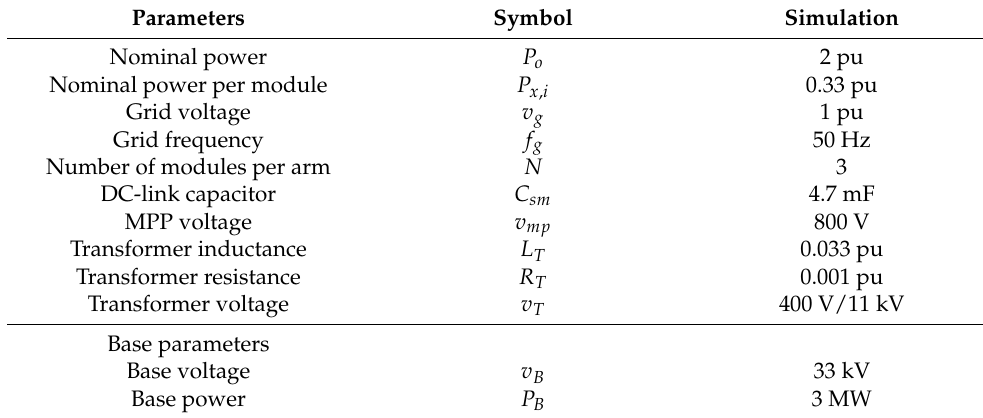
Table 1. Simulation